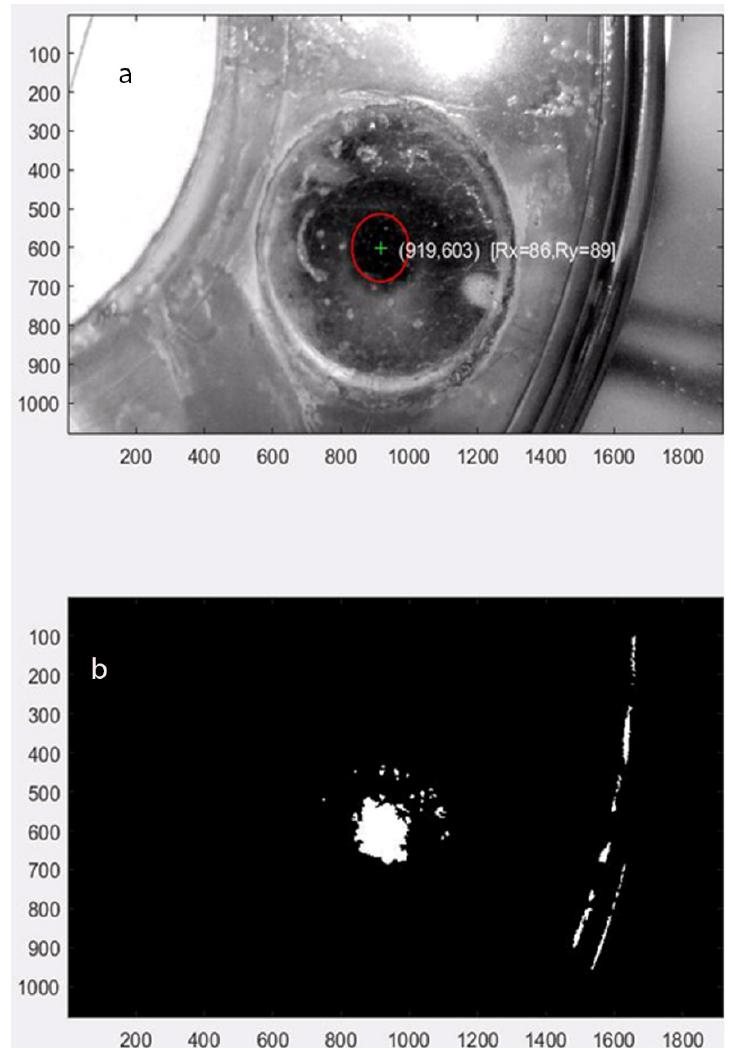
Figure 6. The force measurement setup using prototype: ( a ) force measurement setup ( b ) image processing (black and white) to calculate contact area.